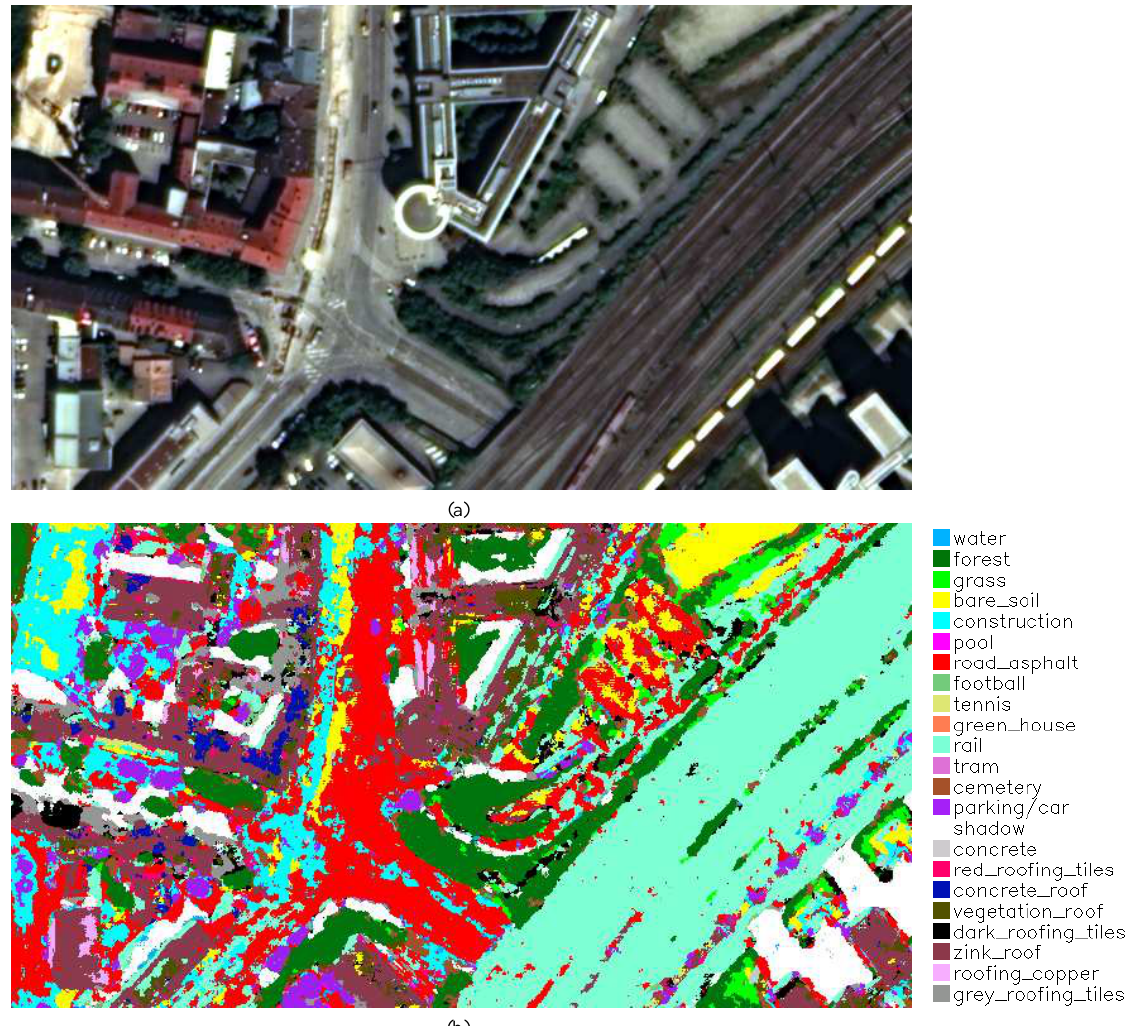
Figure 2: A region of the classification map (INFOFUSE): (a) visible range multispectral image (bands 5,3,2), (b) fusion and classifi- cation by INFOFUSE (this region contains several of the 23 classes)